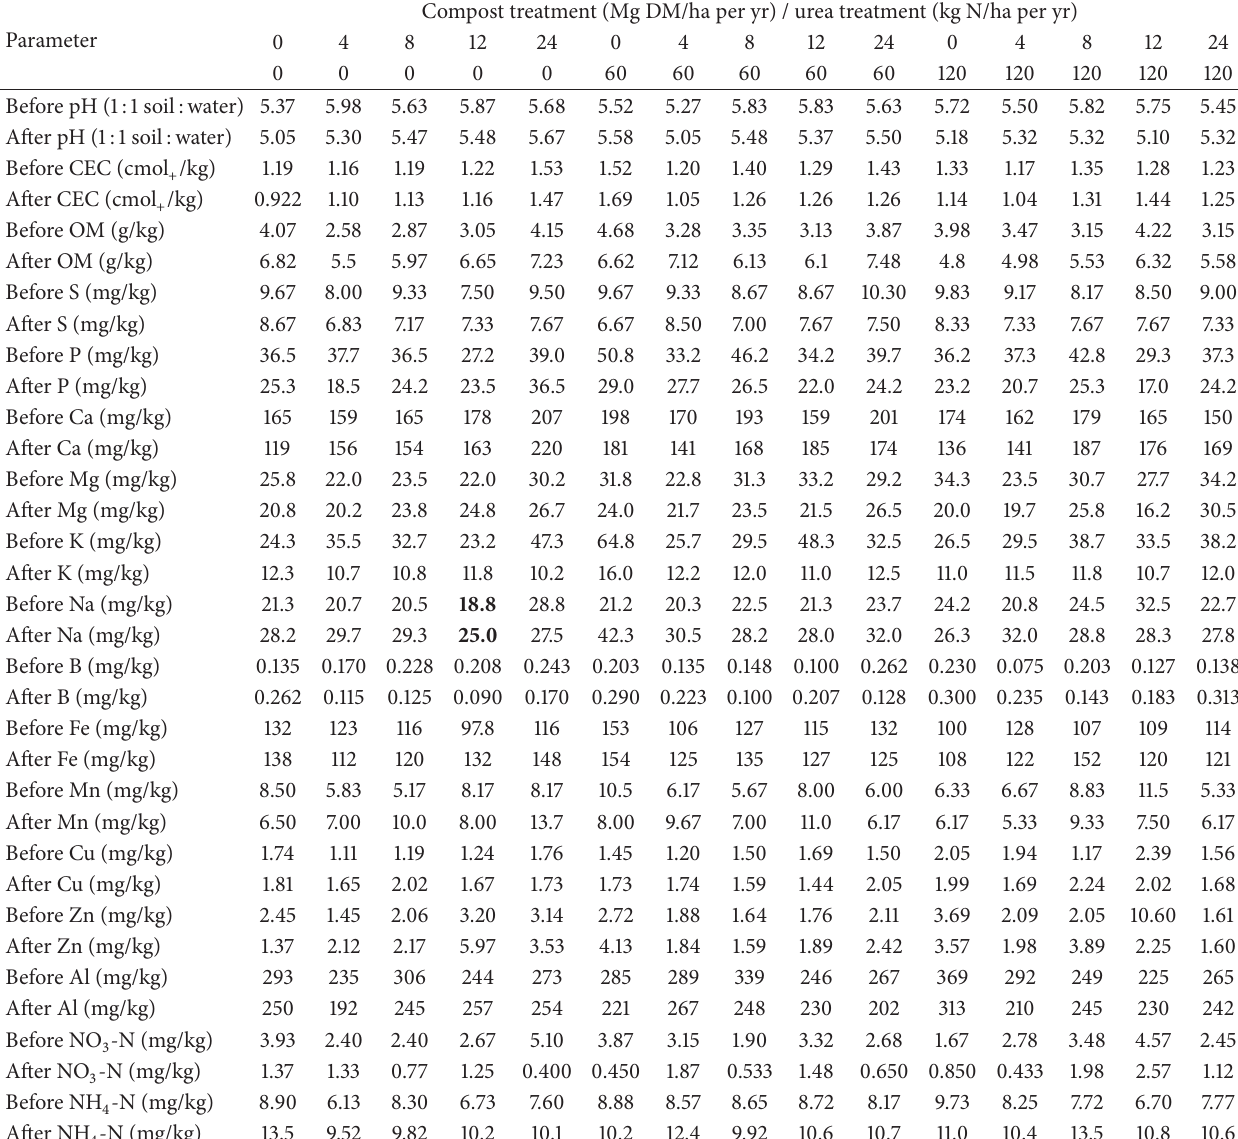
Table 8: Soil fertility means before and after the experiment at the 15 to 25 cm depth for compost × urea treatment combinations. Elements are Mehlich-3 extractable nutrients. Data from before the experiment are included as a treatment baseline. Means calculated in each cell are an average of 6 farms. The only pair that differed significantly based on a paired one-tailed 𝑡 -test, using the Bonferroni-adjusted P value cutoff of 0.003, is in